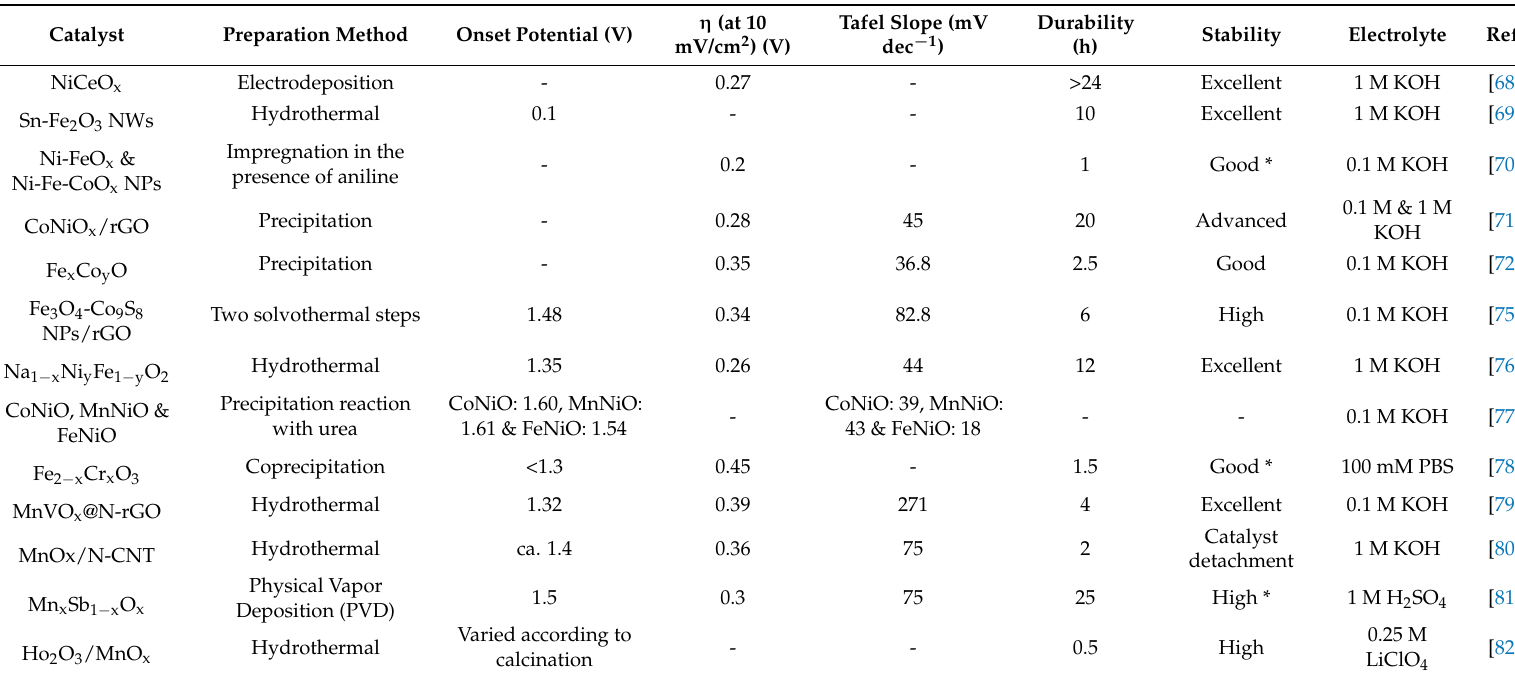
Table 5. Comparison of the electrocatalytic activity of mixed oxide catalysts (cf. Table 1 for definitions of “durability” and “stability”).